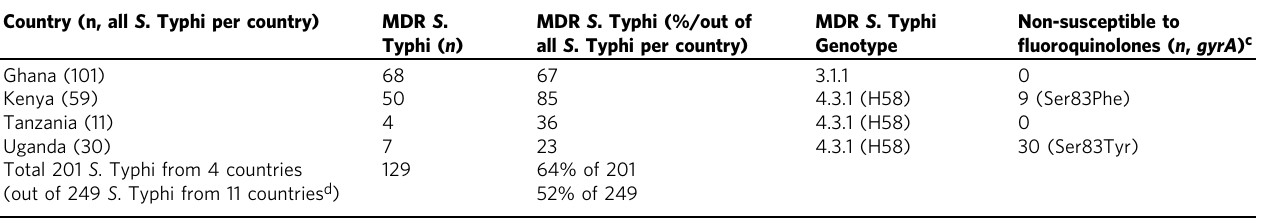
Table 1 Genotypes of MDR a S . Typhi and gyrA in four countries b